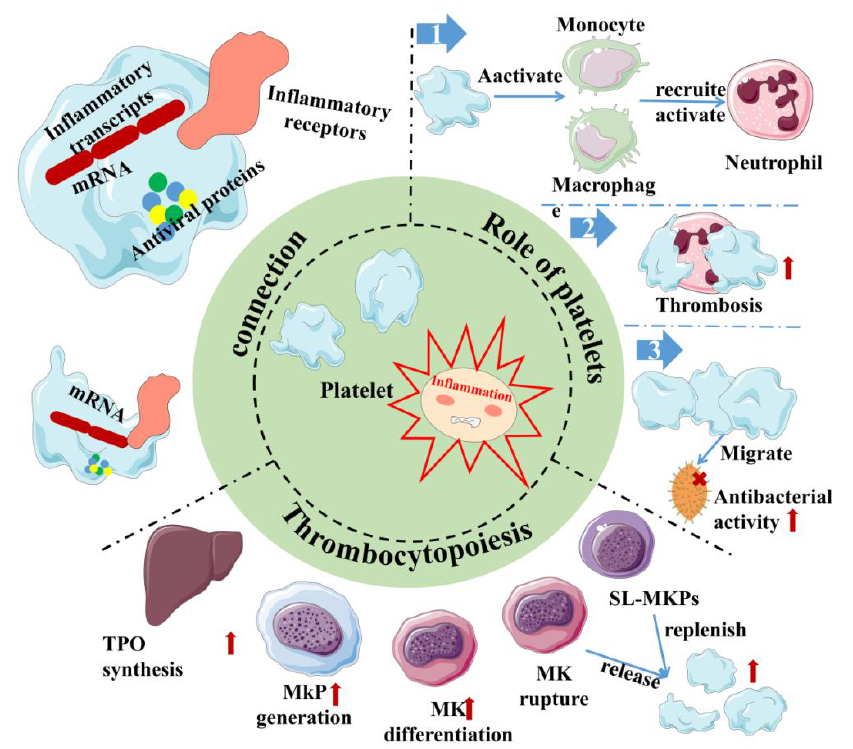
Figure 2. Inflammation and platelet interaction. Platelets are at the junction between inflammation and host defense. Platelets carry not only inflammatory transcripts but also antiviral proteins. Platelets activate/recruit a variety of cells for host defense in inflammation, meanwhile, and inflammation can promote platelet production through multiple channels. Red arrows indicate the enhanced physiological effects. Red “ × ” indicate the role of sterilization. Sl-Mkp: Stem-like megakaryocyte progenitors; TPO: Thrombopoietin; MK: megakaryocyte; MkP: Megakaryocyte progenitor.